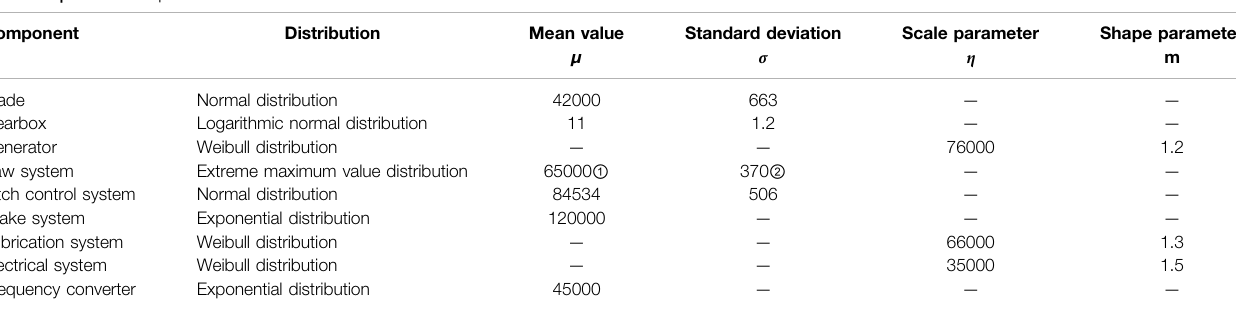
TABLE 3 | Distribution parameters of the units.